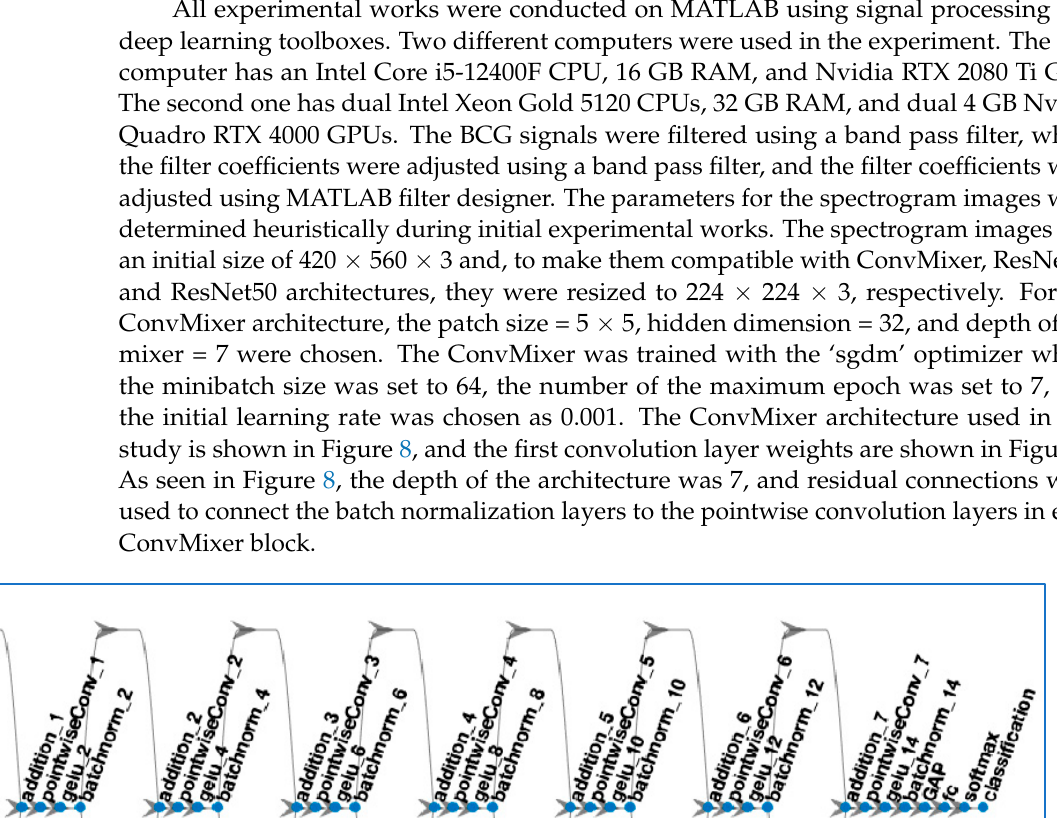
Figure 7. Convolution mixer structure.